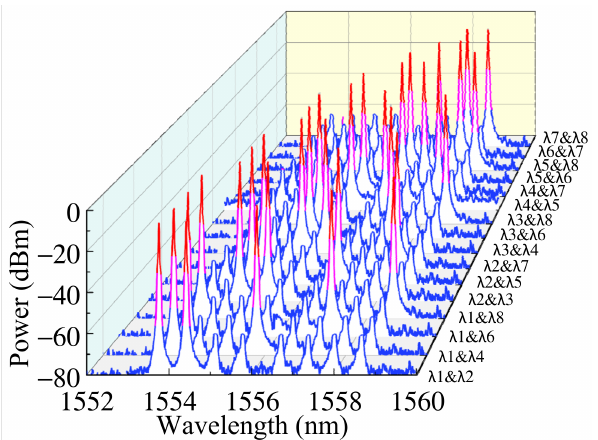
Figure 10. Spectra of the dual-wavelength switchable operation with orthogonal polarization